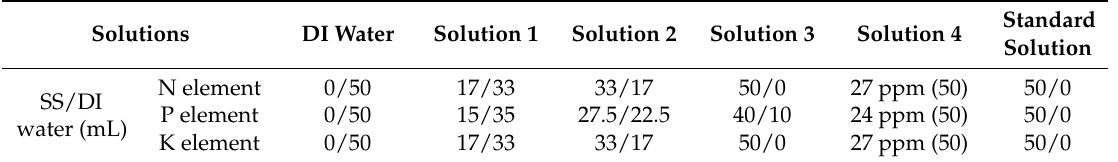
Table 1. Solutions preparation list.